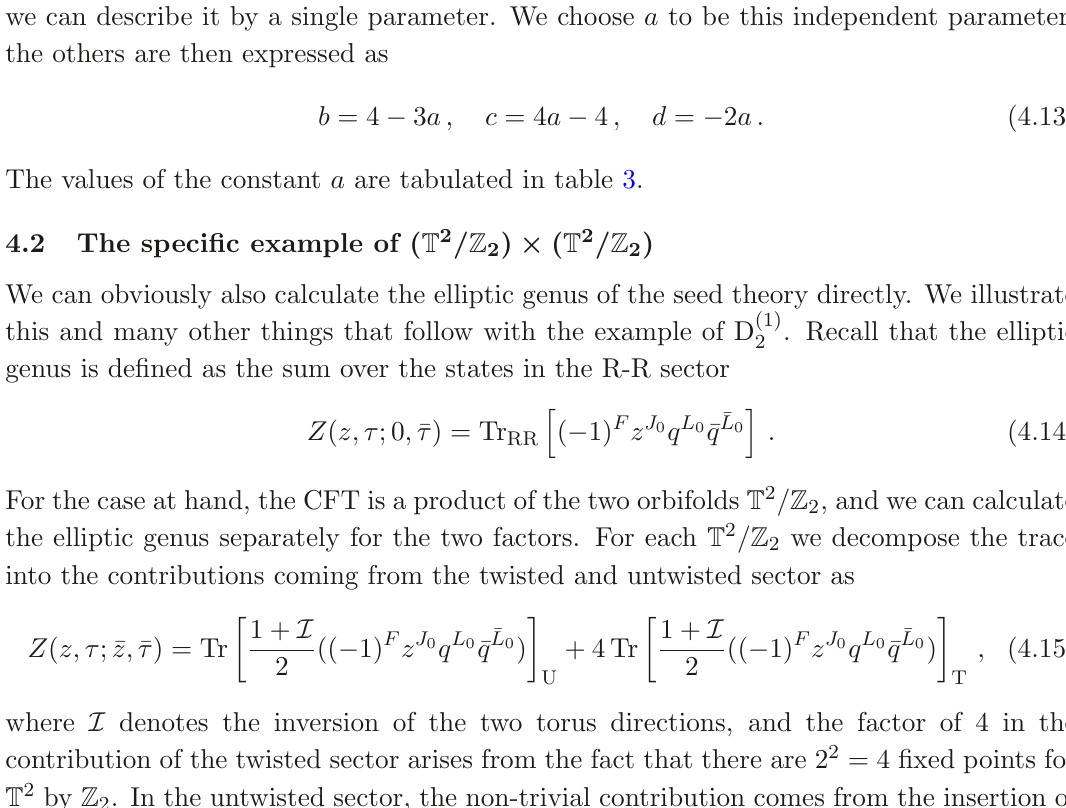
Table 3 . Parameters of the elliptic genera of the different models. The doubled elliptic genus is then given by (4.9). The theories with tilde are the versions with discrete torsion. holds (for n ≥ 2), and thus, provided that the elliptic genus is non-vanishing (i.e. for n ≥